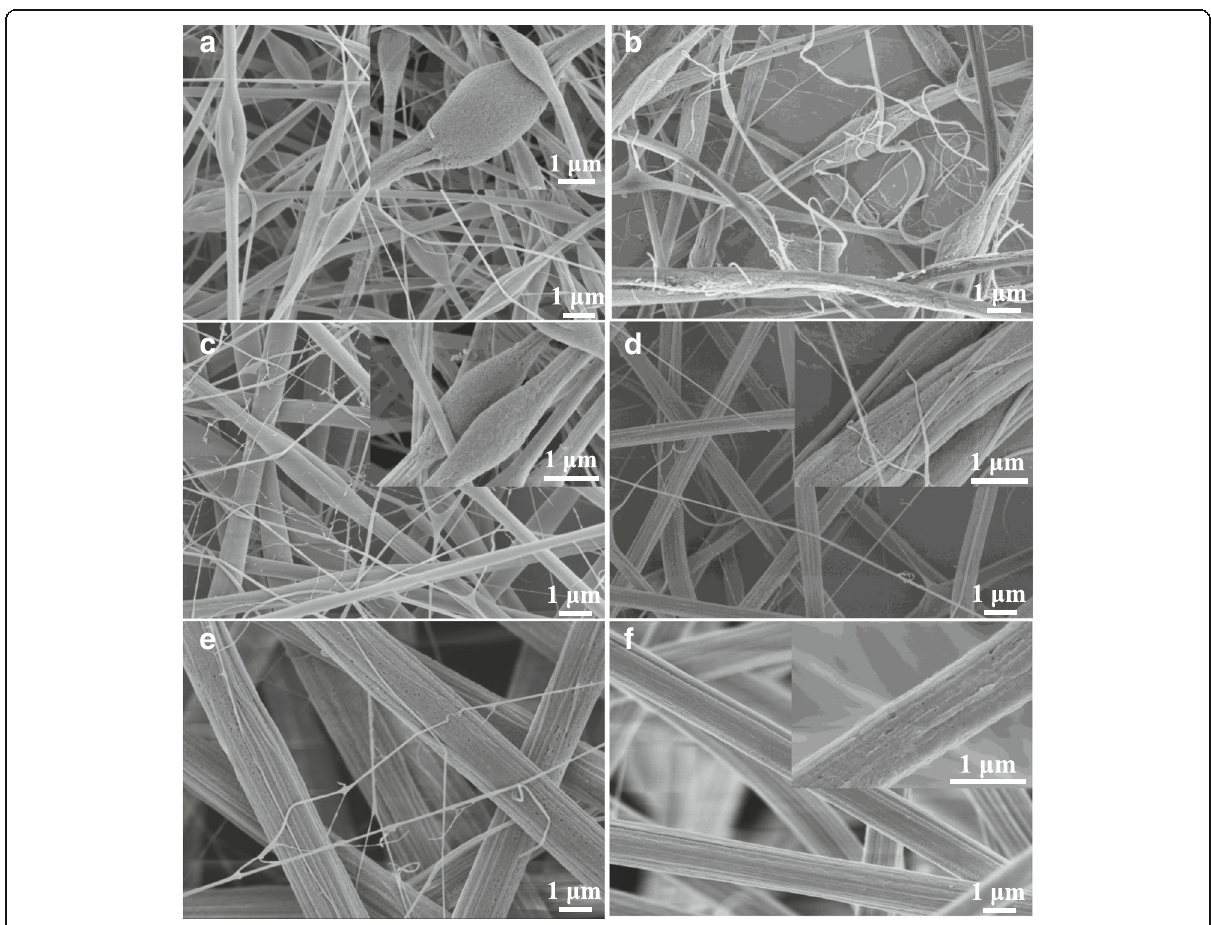
Fig. 1 FESEM pictures PAN/PS fibers with different concentration. a PAN/PS-10 wt%, b PAN/PS-12 wt%, c PAN/PS-14 wt%, d PAN/PS-16 wt%, e PAN/PS-18 wt%, f PAN/PS-20 wt%